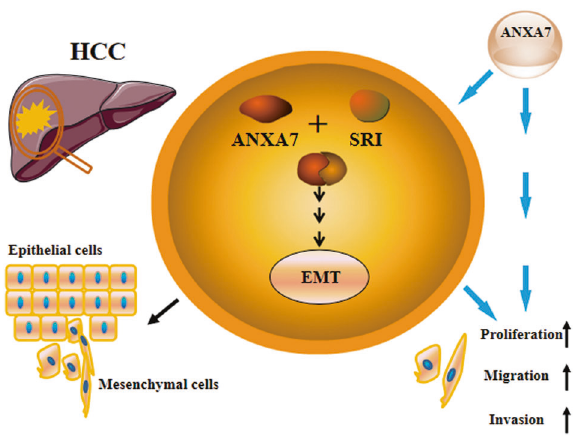
Fig. 8 Proposed schematic diagram about the mechanism of ANXA7 in HCC. Interaction between ANXA7 and SRI affects EMT progress and contributes to the aggressiveness in